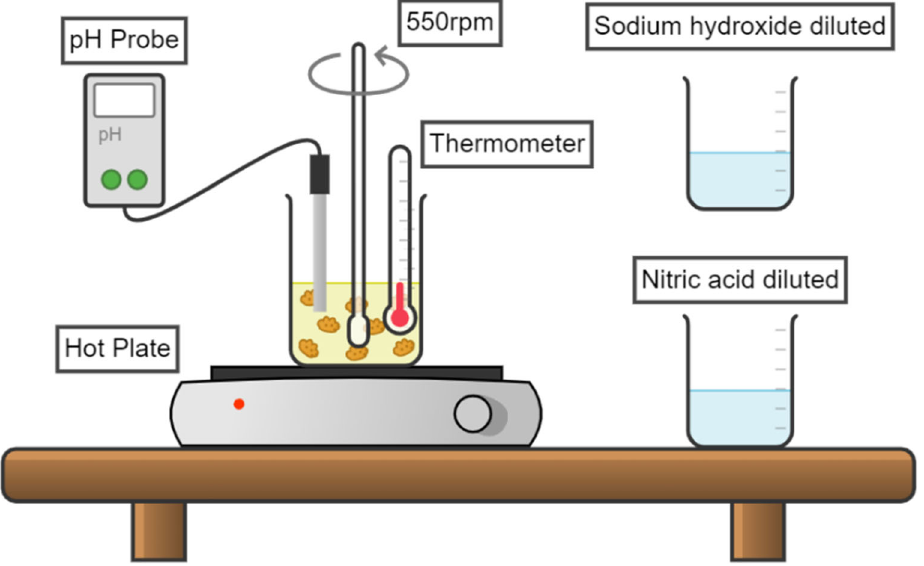
Figure 2. Experimental setup for the alkaline decomposition of potassium jarosite and incorpora ‐ tion of As(V). of